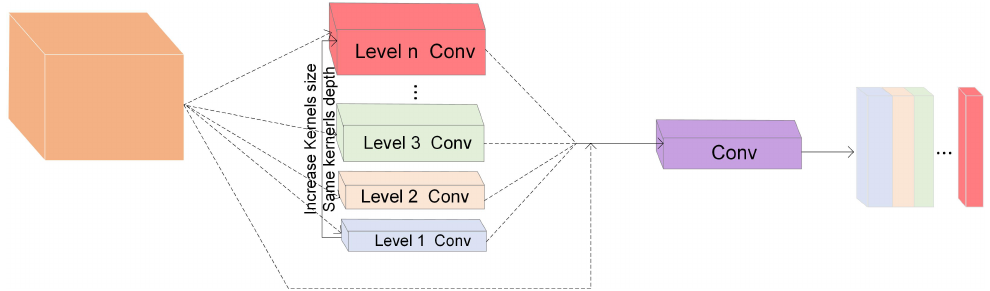
Figure 7. Multi-streamnet structure schematic. By using the same convolution depth for different scales of convolution kernels on top of PyConv, adding residual connections and incorporating detection layer